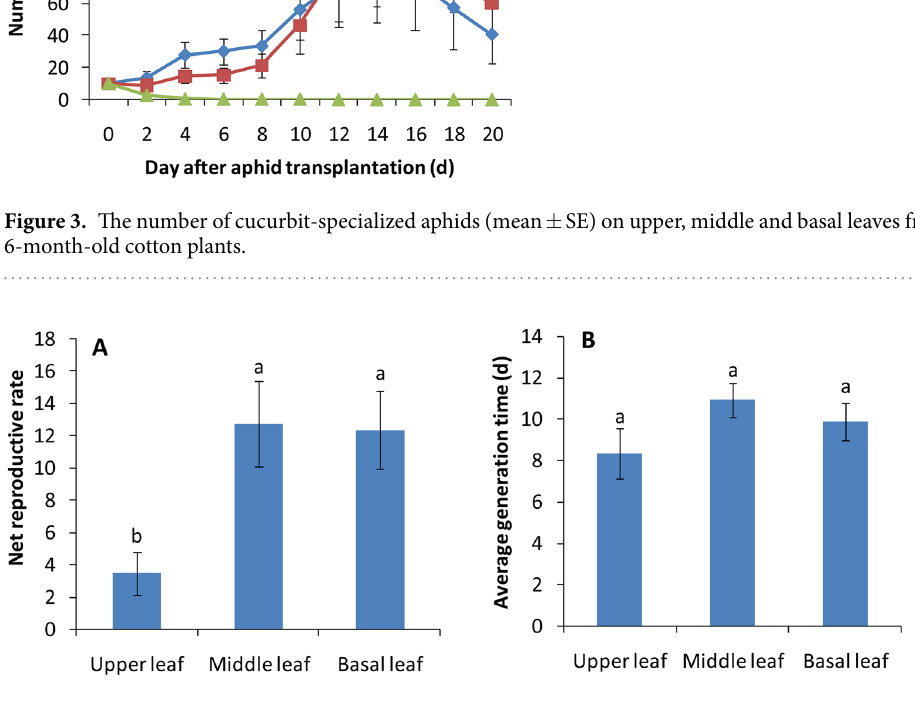
Figure 4. Net reproductive rate ( A ) and average generation time ( B ) of cucurbit-specialized aphids on upper, middle and basal leaves of cotton seedlings with 10 leaves (mean ±